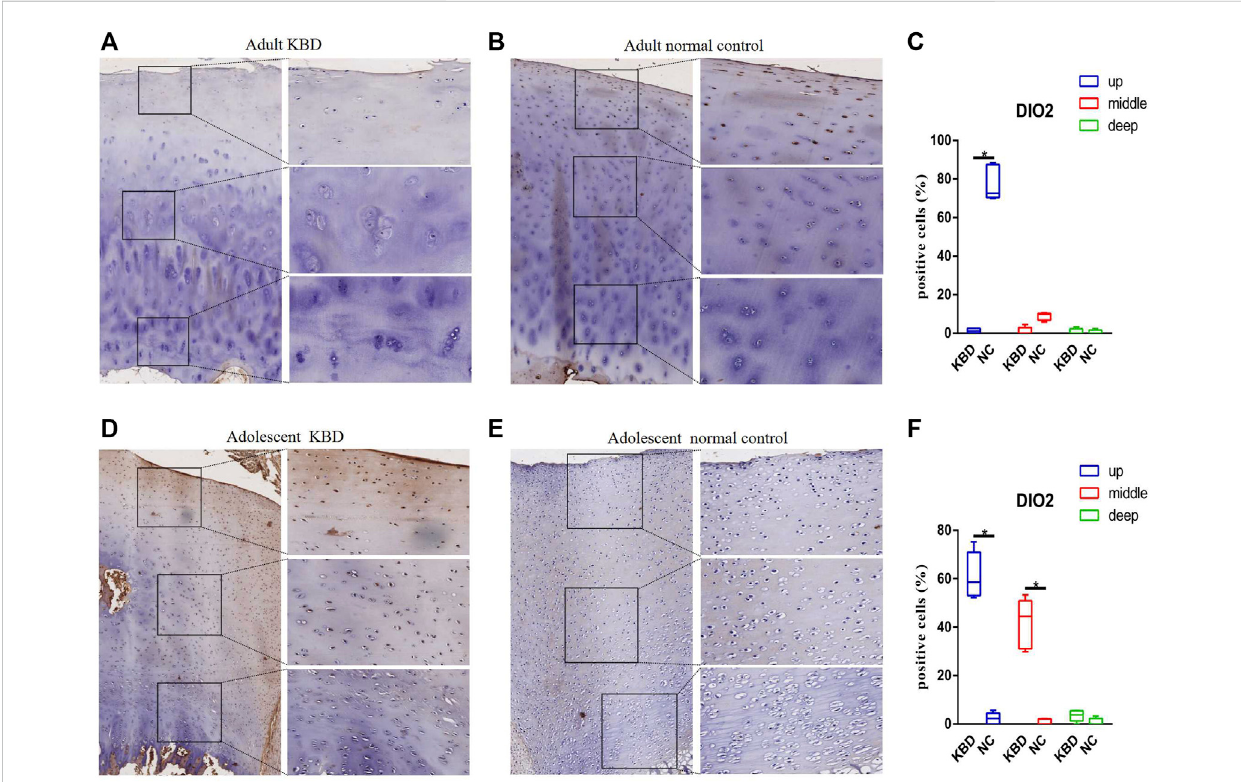
FIGURE 5 Representative immunohistochemistry staining of DIO2 in adult KBD (A) , adult normal control (B) , adolescent KBD (D) , and adolescent normal control (E) cartilagetissues(scalebar:left,500 μ m;right,100 μ m)andcomparativequanti fi cationofpositivecellsofdifferentareas(up,middle,anddeep) in adult (C) and adolescent (F) cartilage tissues displayed by a box plot ( n = 3). * p <